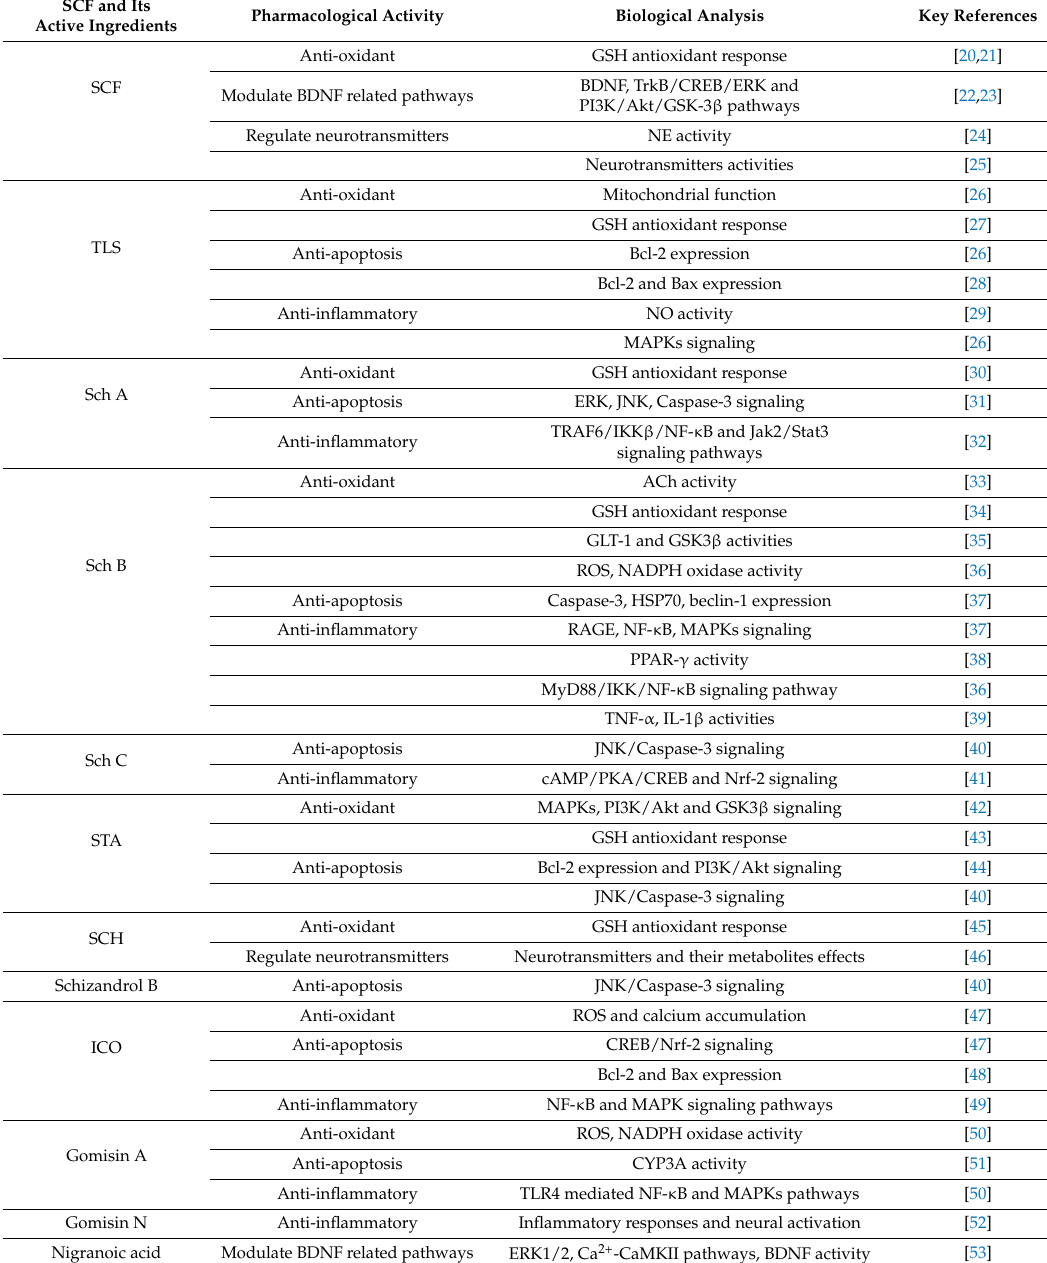
Table 1. Summary of the pharmacological effects and biological analysis of Schisandra chinensis Fructus (SCF) and its active ingredients. BDNF—brain-derived neurotrophic factor; CREB—cAMP-response element binding protein; PI3K—phosphatidylinositol